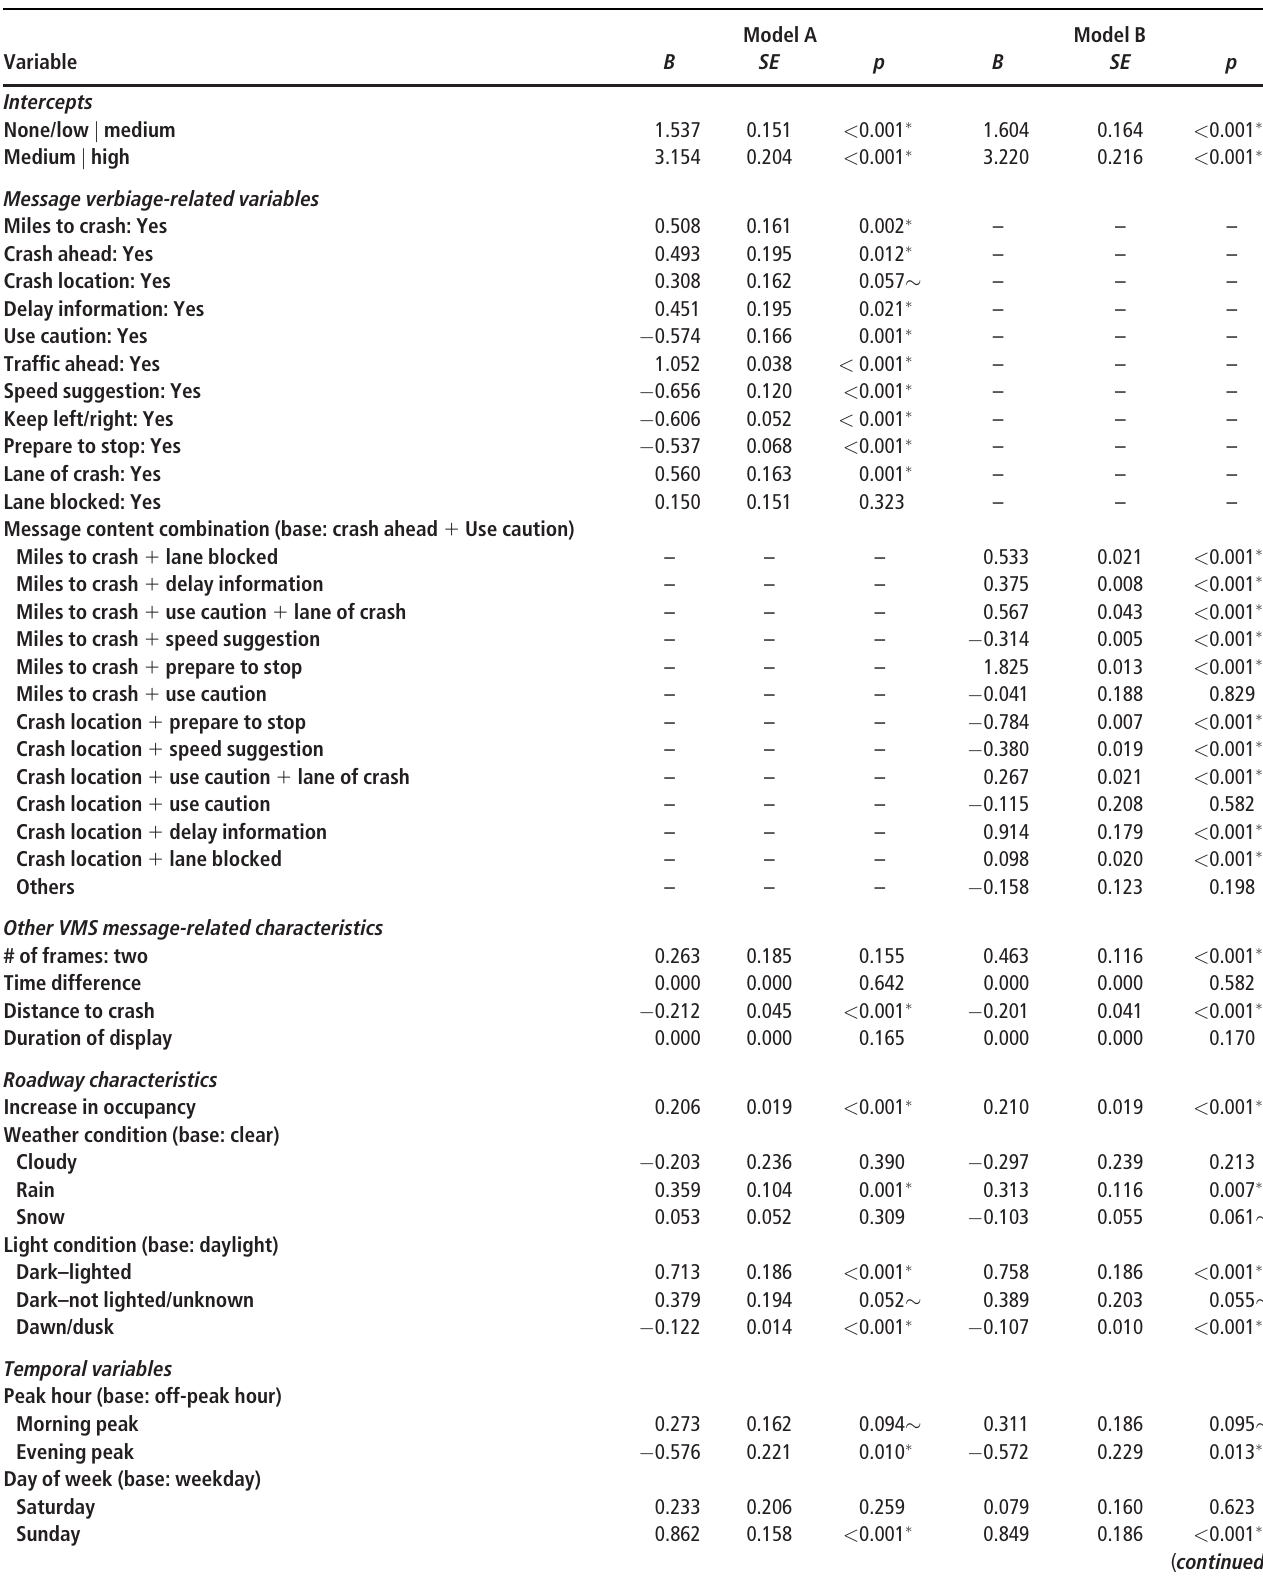
Table 3 Results of ordered logit models of increase in diversion